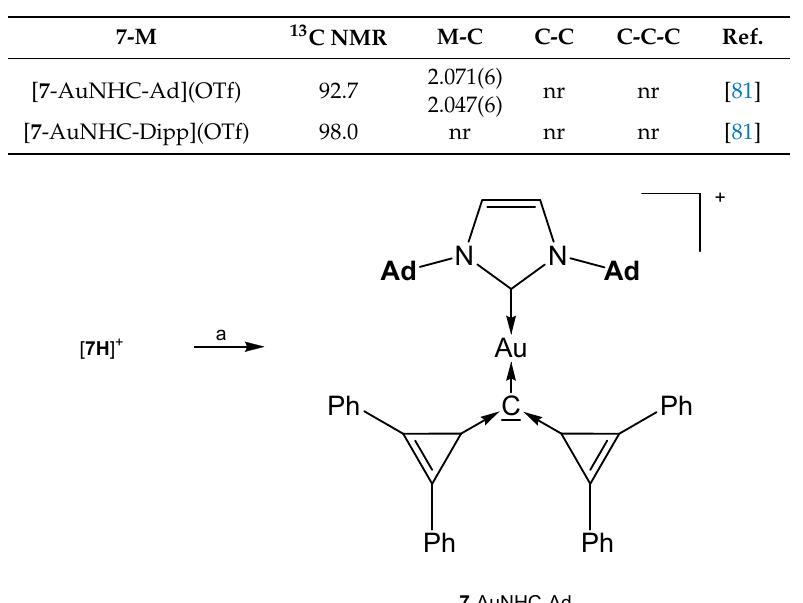
Table 7. Complexes with the carbone 7. 13 C NMR shifts (in ppm) of the donating carbon atom.